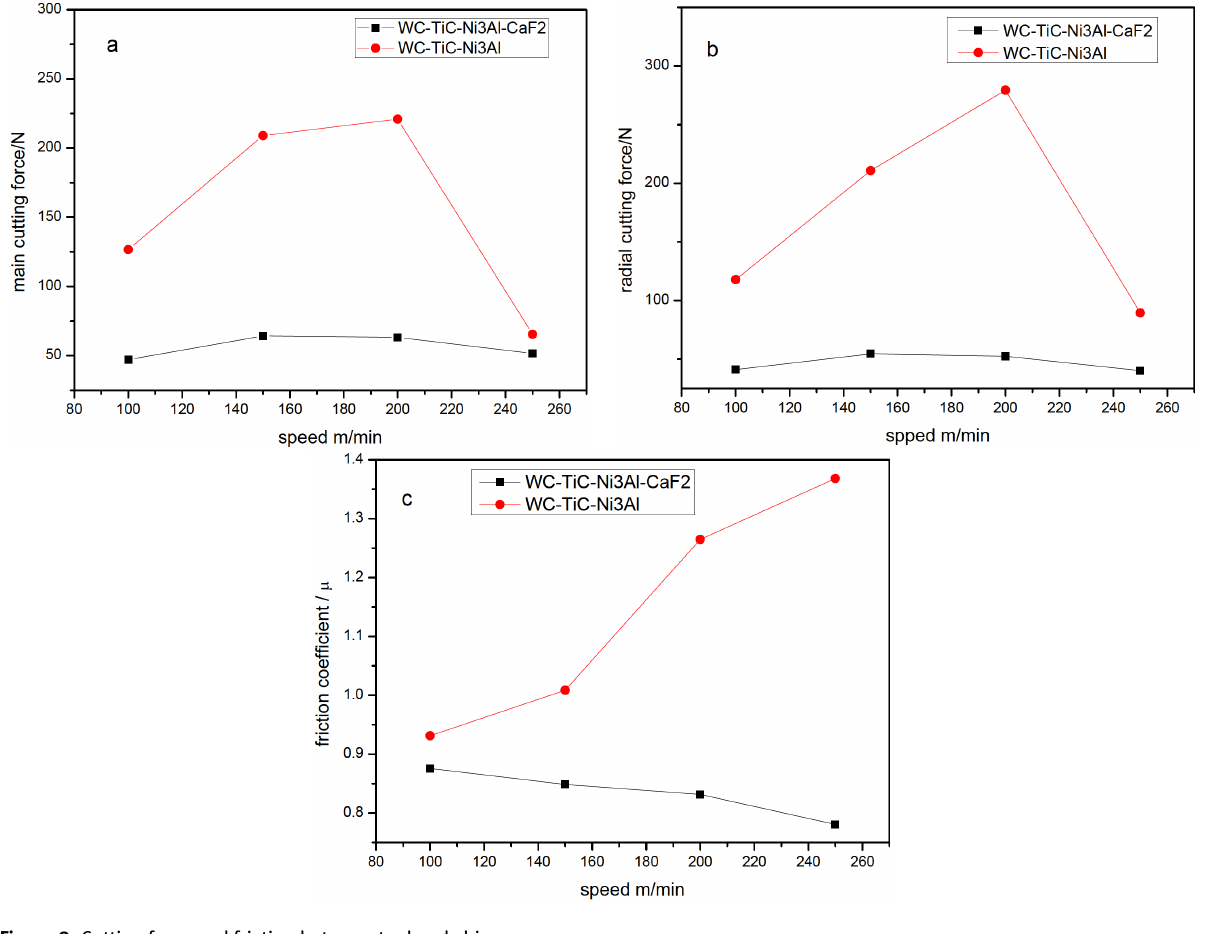
Figure 8: Cutting force and friction between tool and